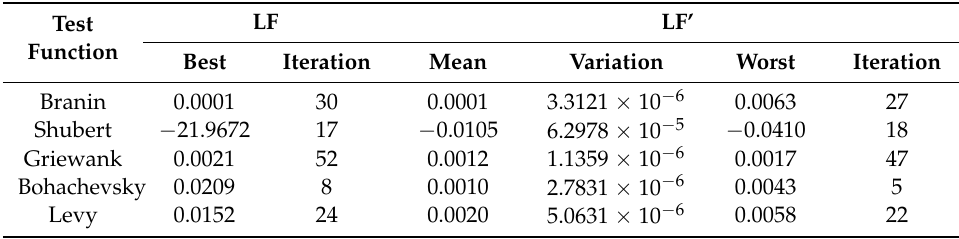
Table 2. Test result comparison between the LF and the